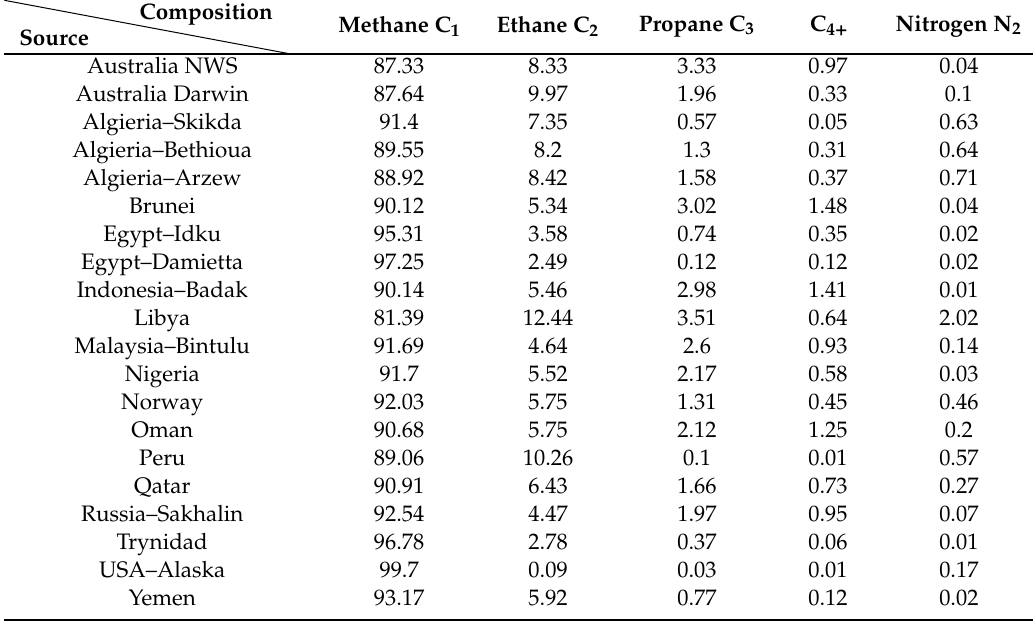
Table 4. LNG compositions from various export sources